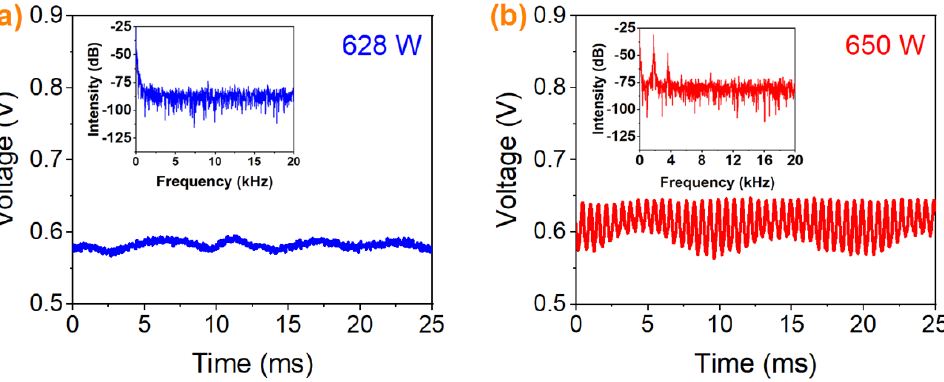
Figure 4. Signals for temporal intensity. Inset: corresponding Fourier spectra. ( a ) At 628 W. ( b ) At 650 W.